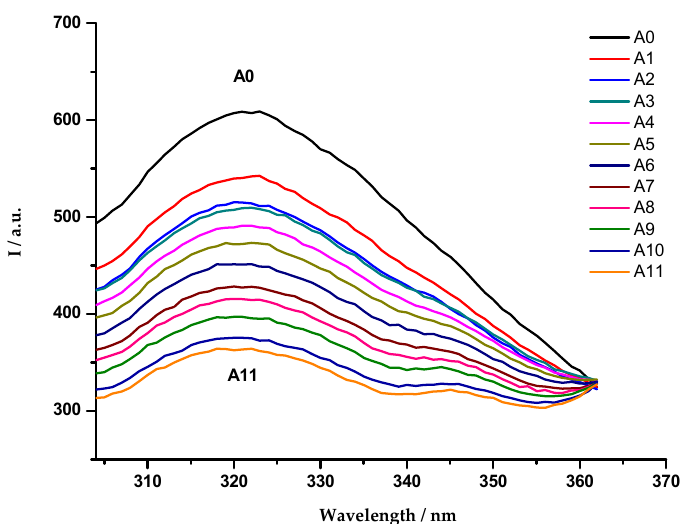
Figure 1. Emission fluorescence spectra of OmpF WT/ E. coli total lipid extract proteoliposomes, in the absence (A0) and presence (A1–A11) of cpx solution (A1: 7.0 µ mol dm − 3 ; A2: 8.1 µ mol dm − 3 ; A3: 9.3 µ mol dm − 3 ; A4: 10.4 µ mol dm − 3 ; A5: 11.5 µ mol dm − 3 ; A6: 12.6 µ mol dm − 3 ; A7: 13.7 µ mol dm − 3 ; A8: 14.8 µ mol dm − 3 ; A9: 15.9 µ mol dm − 3 ; A10: 16.9 µ mol dm − 3 ; A11: 18.0 µ mol dm − 3 ), with excitation wavelength of 290 nm. Each spectrum is a mean of five replicate measurements.